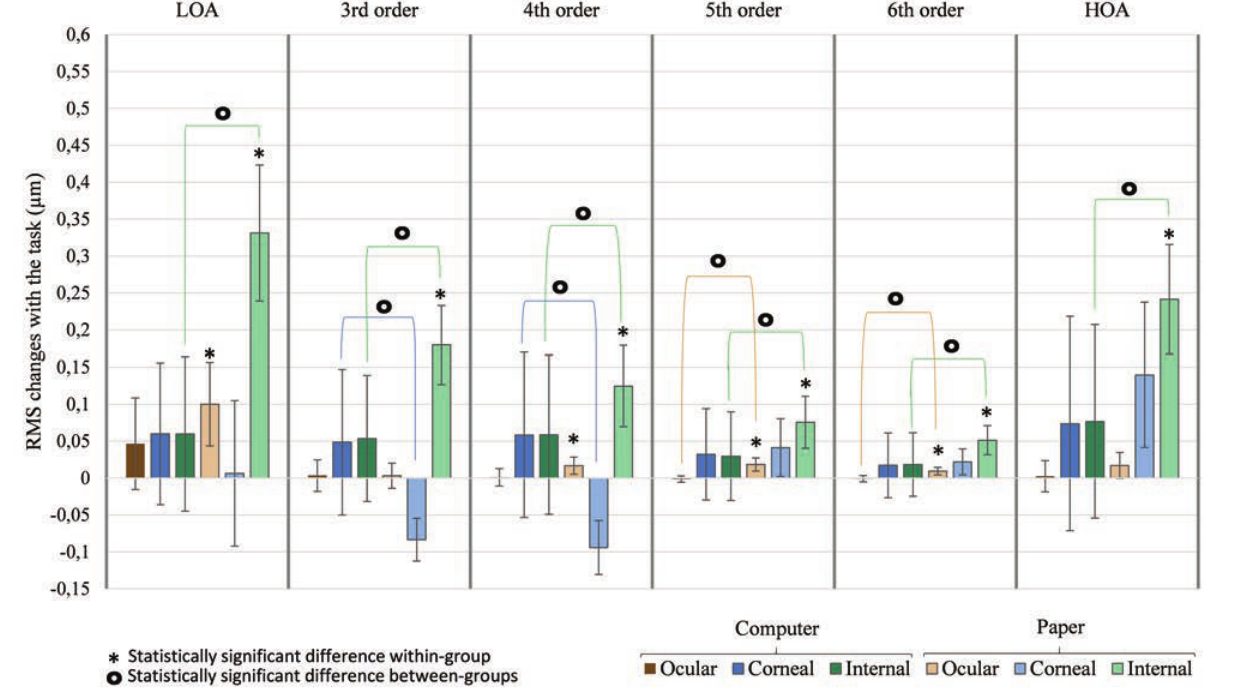
Figure 1. Changes in ocular, corneal, and internal RMS of third, fourth, fifth, and sixth-order aberrations and HOA between pre and post task conditions in both computer and paper groups, with 95%-confidence-interval error bars. There is a statistically significant increase of ocular, corneal, and internal RMS in several orders in the paper group and no statistically significant changes in the computer group. The changes in the paper group were significantly greater than the changes in the computer group.